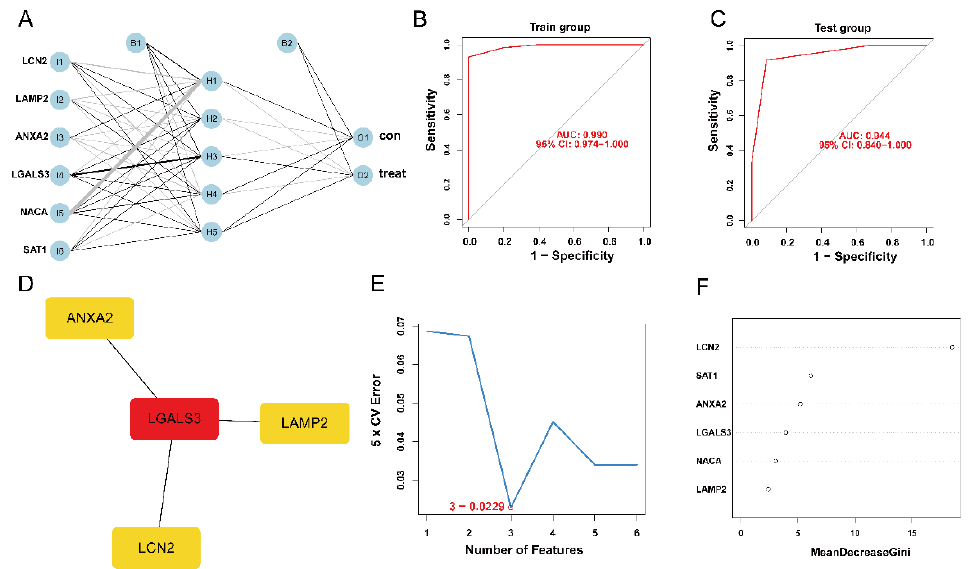
Figure 3. The construction of HIBD classification model and identification of gene biomarkers for HIBD. ( A ) Visualization of artificial neural network results. ( B , C ) The ROC curves were utilized to evaluate the performance of the HIBD classification model in training and validation datasets. ( D ) CytoHubba detected four ferroptosis-HIBD genes. ( E ) Three genes were identified by the SVM-RFE algorithm with an error of 0.0229. ( F ) A minimum error regression tree was established for six ferroptosis-HIBD genes.